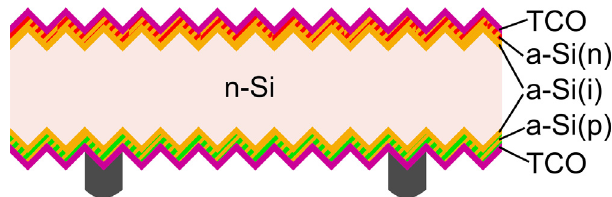
Fig. 1. Schematic cross section of the simulated HJT solar cell without front